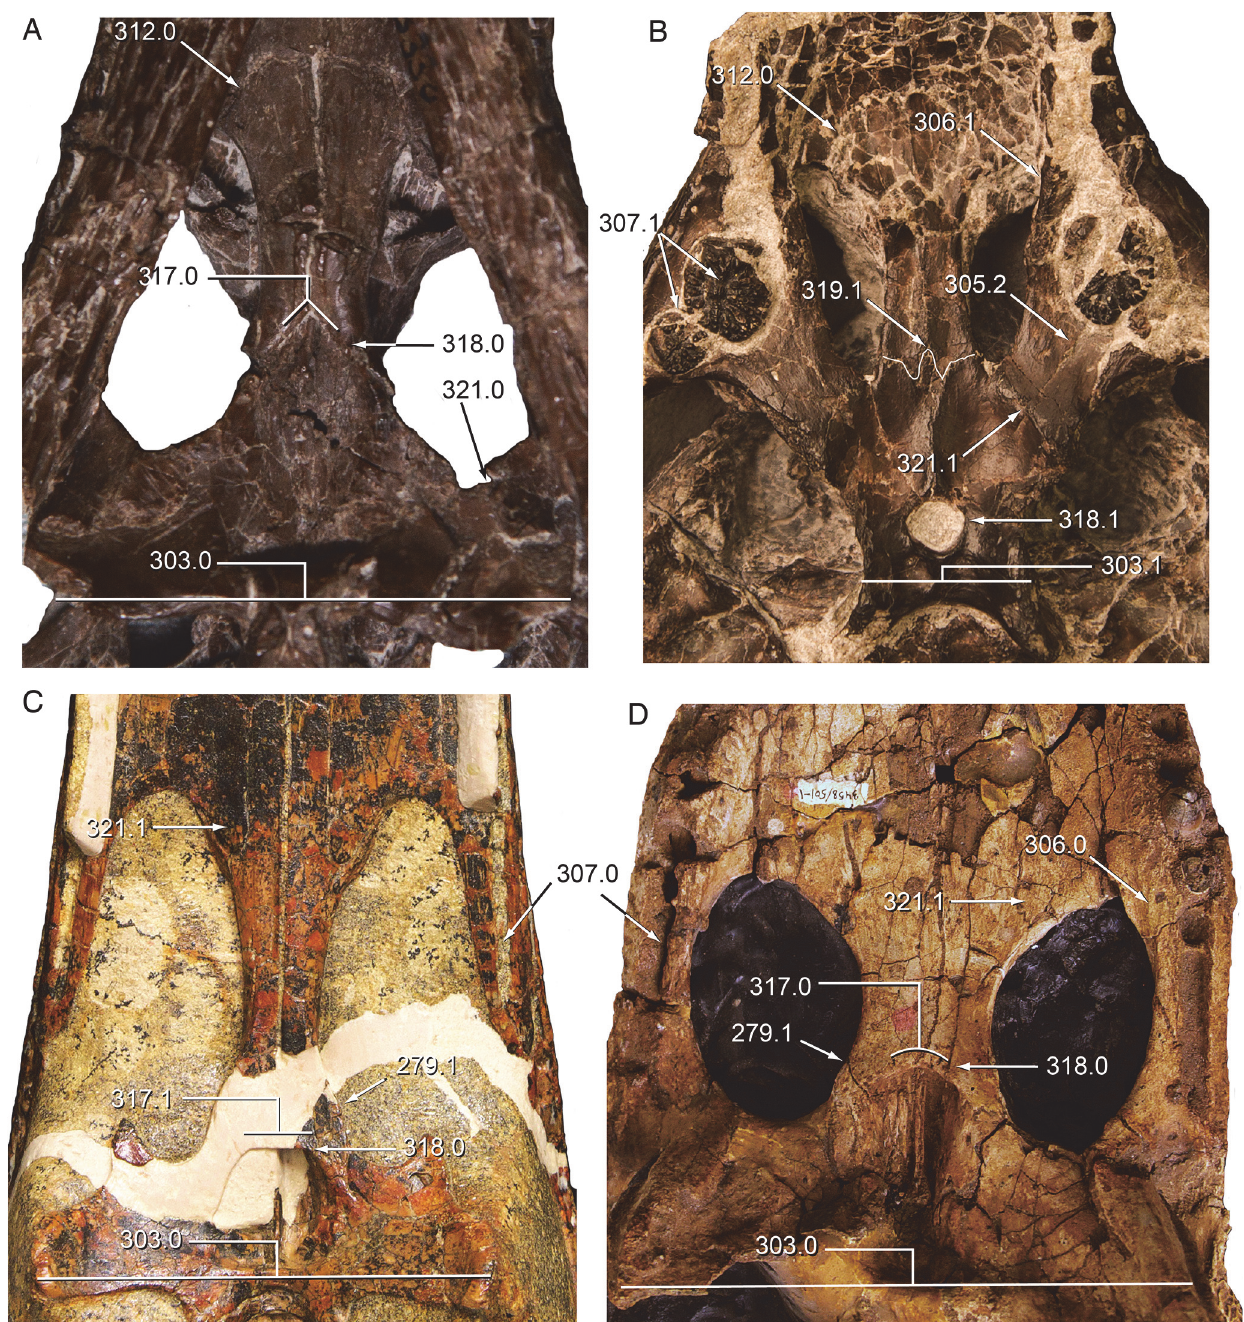
Fig 15. Systematic variation in palate morphology among neosuchians. Numbers indicate character number from phylogenetic dataset using in this study, with state value following the period (i.e., char.charstate). A , Theriosuchus pusillus (NHMUK 48330); B , Iharkutosuchus makadii (MTM 2006.53.1); C , Isisfordia duncani (QM F44320); D , Shamosuchus ulgicus (= Paralligator gradilifrons ) (PIN